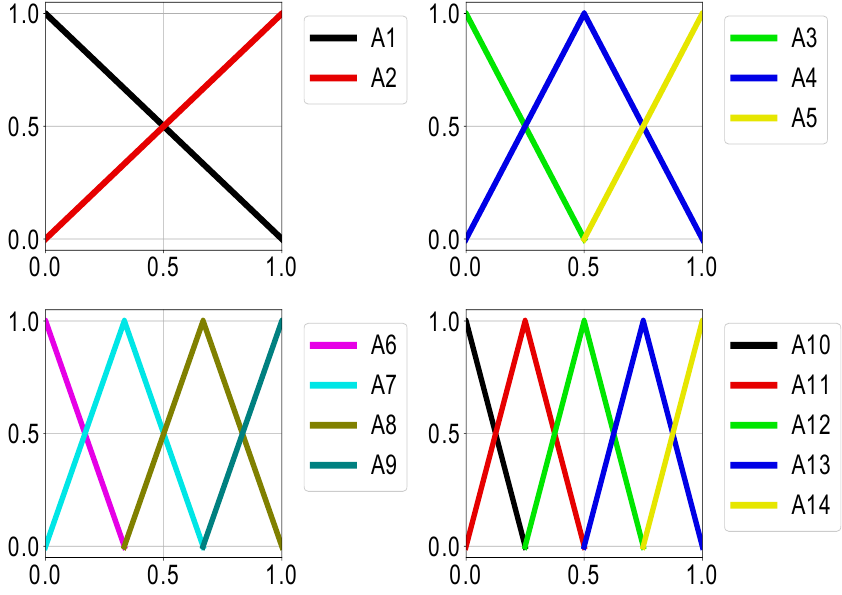
Figure 1. Fuzzy granulation into 2, 3, 4 and 5